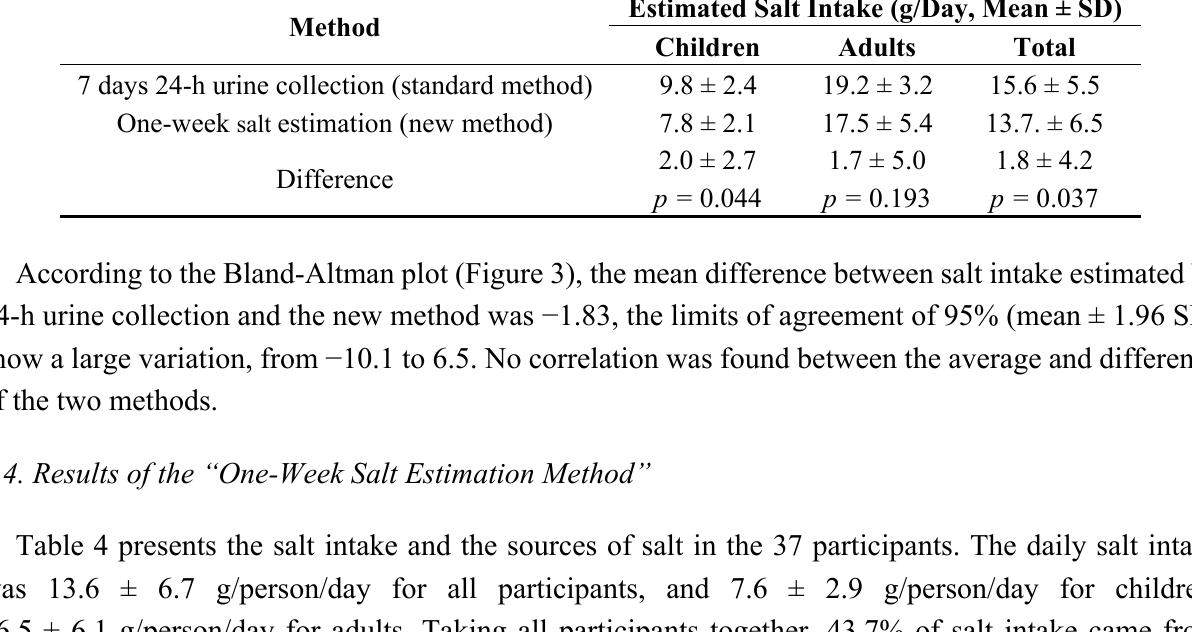
Figure 2. Person correlations between salt measured by 24-h urine collection and “one-week salt estimation method” ( n = 26). Table 3. Difference of salt intake measured by 24-h urine collection and “one-week salt estimation method” ( n =